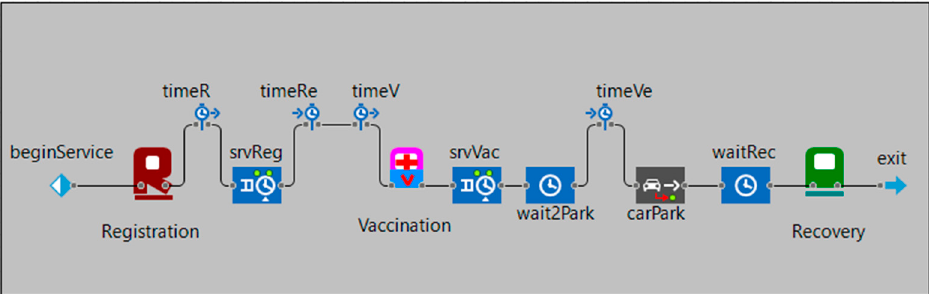
Figure 2. The service lanes flowchart of the drive-through mass vaccination simulation tool. Table 1. Parameter settings for the sample drive-through simulation